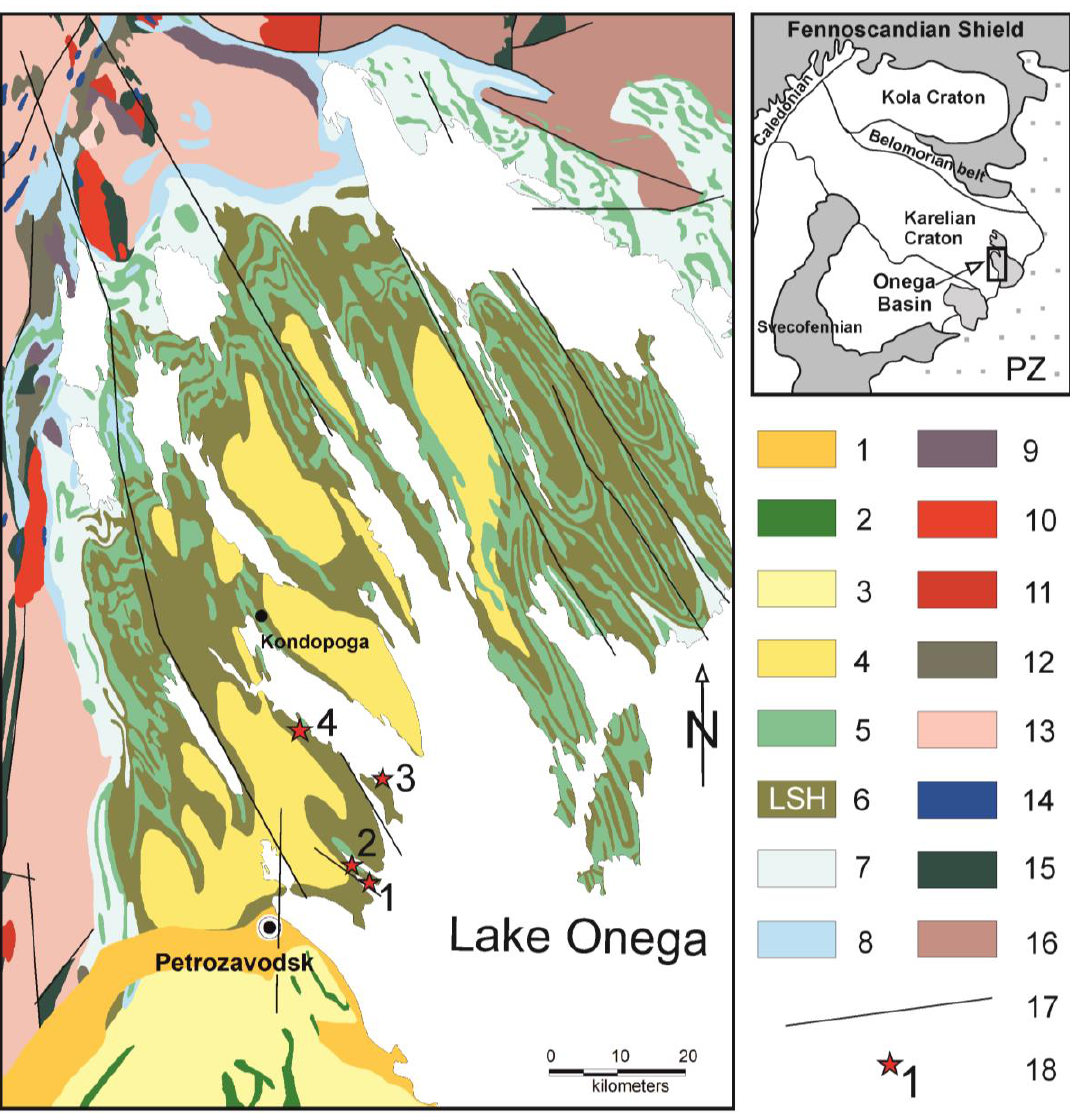
Figure 1. Simplified geological map of the northwestern part of the Onega Basin (based on [34]) and position of studied areas. Legend. Neoproterozoic: 1 — ca. 635−542 Ma sandstones, siltstones,